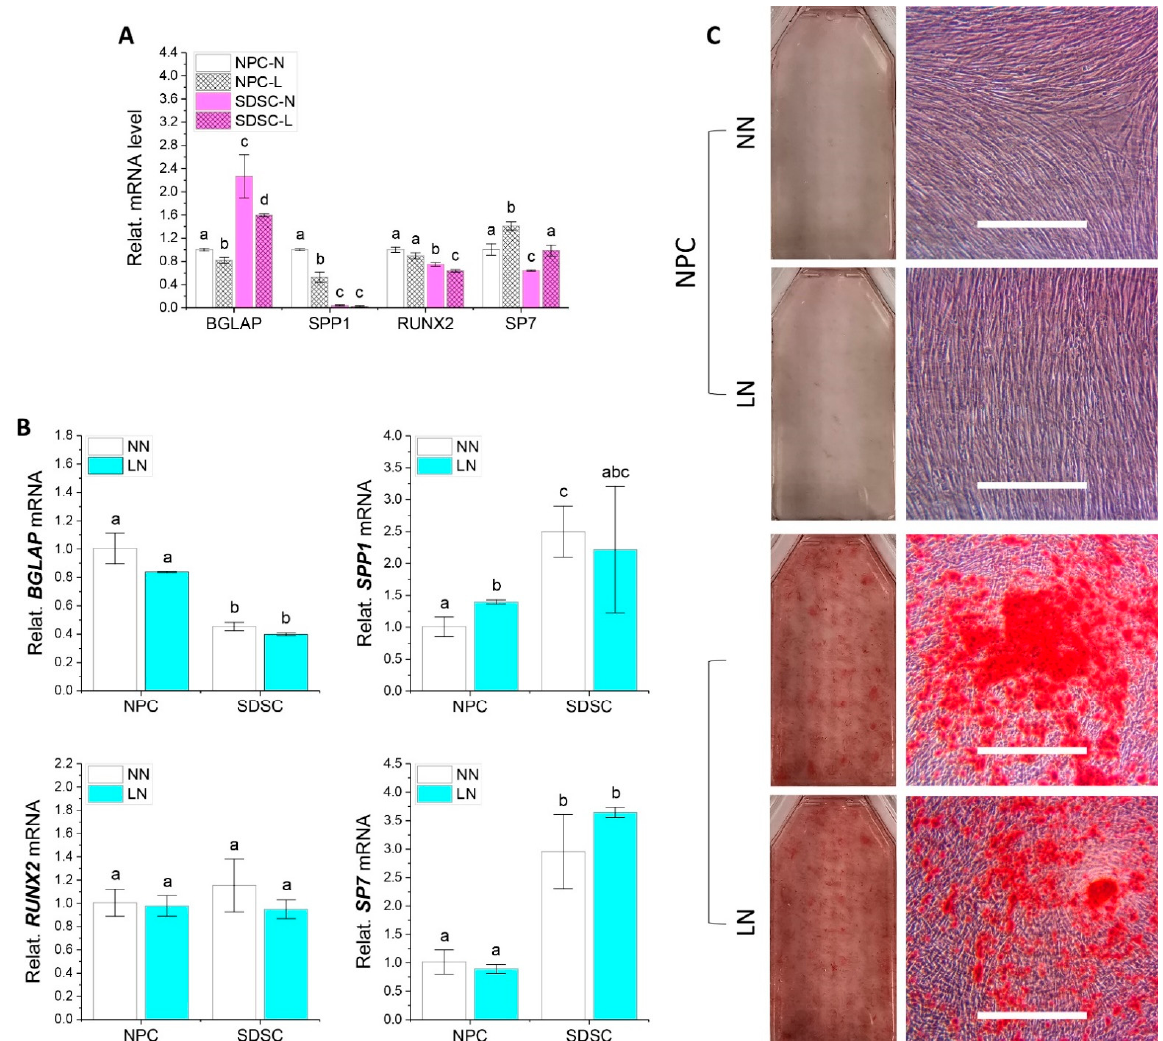
Figure 6. Evaluation of the effect of hypoxia pretreatment on osteogenic potential of fetal MSCs. Fetal NPCs and SDSCs after normoxia (N) or hypoxia treatment (L) were incubated for 21 days in osteogenic induction medium. Osteogenic marker genes BGLAP , SPP1 , RUNX2 , and SP7 were assessed using RT-qPCR before ( A : cell sample) and after induction ( B : day 21 samples), normalized against GAPDH levels as an internal control. Data ( n = 4) are represented in bar charts. Different letters indicate a statistically significant difference compared to the groups within the same gene type ( p < 0.05). Alizarin Red S (ARS) staining was used to detect bone nodules ( C ).